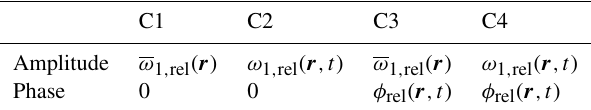
Table 1. Summary of the treatment of the relative rf amplitude and phase for the four cases